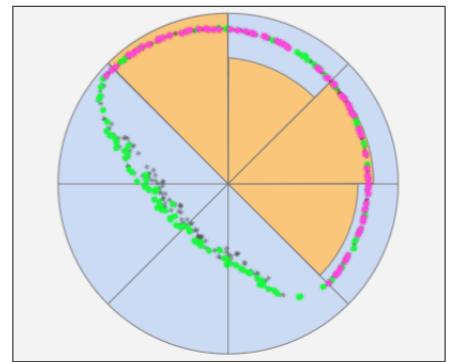
Figure 2. Graphical representation of sector binning. In this example, the K parameter is set to 8 and 4 sectors are active. The orange circular sectors represent the number of points that lies inside the corresponding